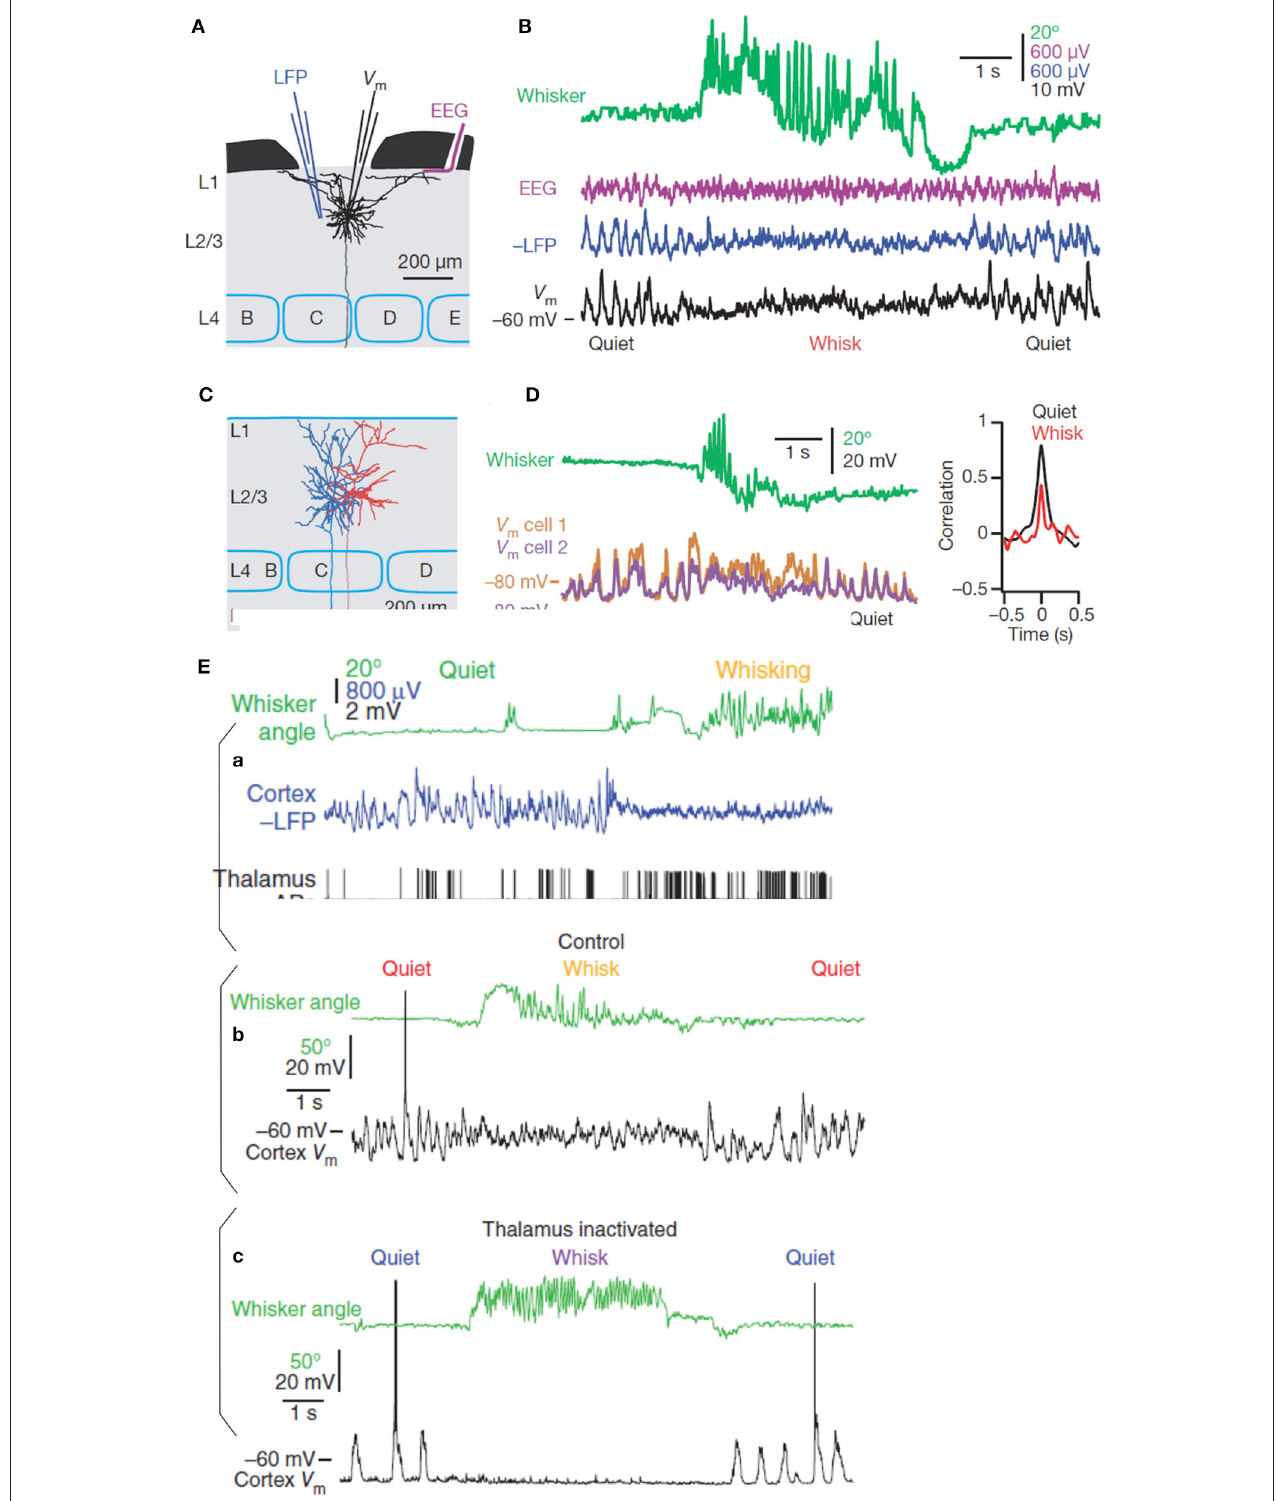
FIGURE 2 | (A) Recording configuration (simultaneous EEG, LFP, and whole-cell recordings) in the mouse somatosensory cortex (Barrel cortex) and reconstruction of one excitatory pyramidal neuron (black) of the layer 2/3. (B) From top to bottom, movement of the whisker (green) defining quiet and whisking periods, EEG